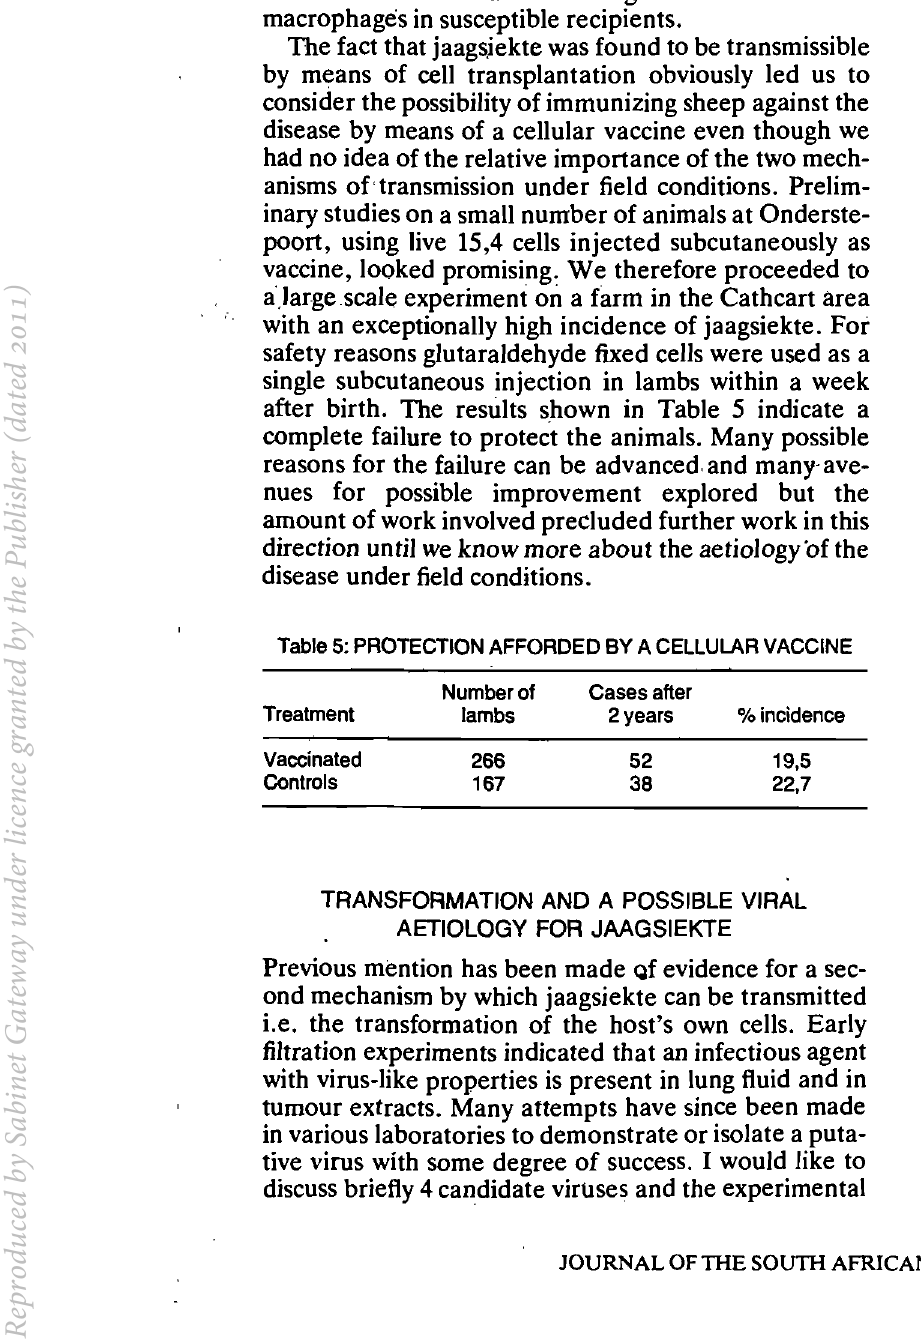
Table 5: PROTECTION AFFORDED BY A CELLULAR VACCINE Treatment Vaccinated